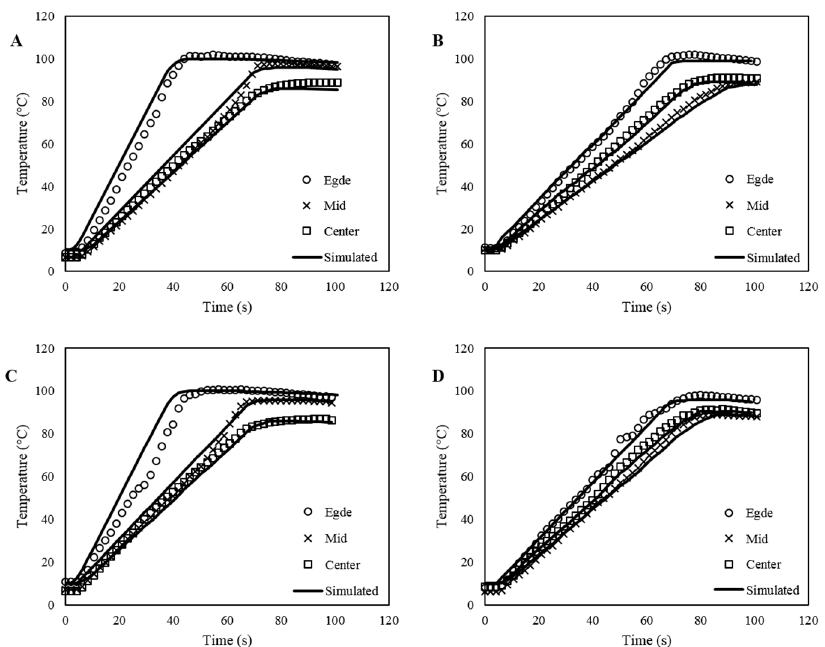
Figure 11. Simulated and experimental time–temperature profile at three locations for PL ( A ), PS ( B ), PW ( C ), and PSW patties ( D ) during microwave heating in the tray with a center-perforated lid.